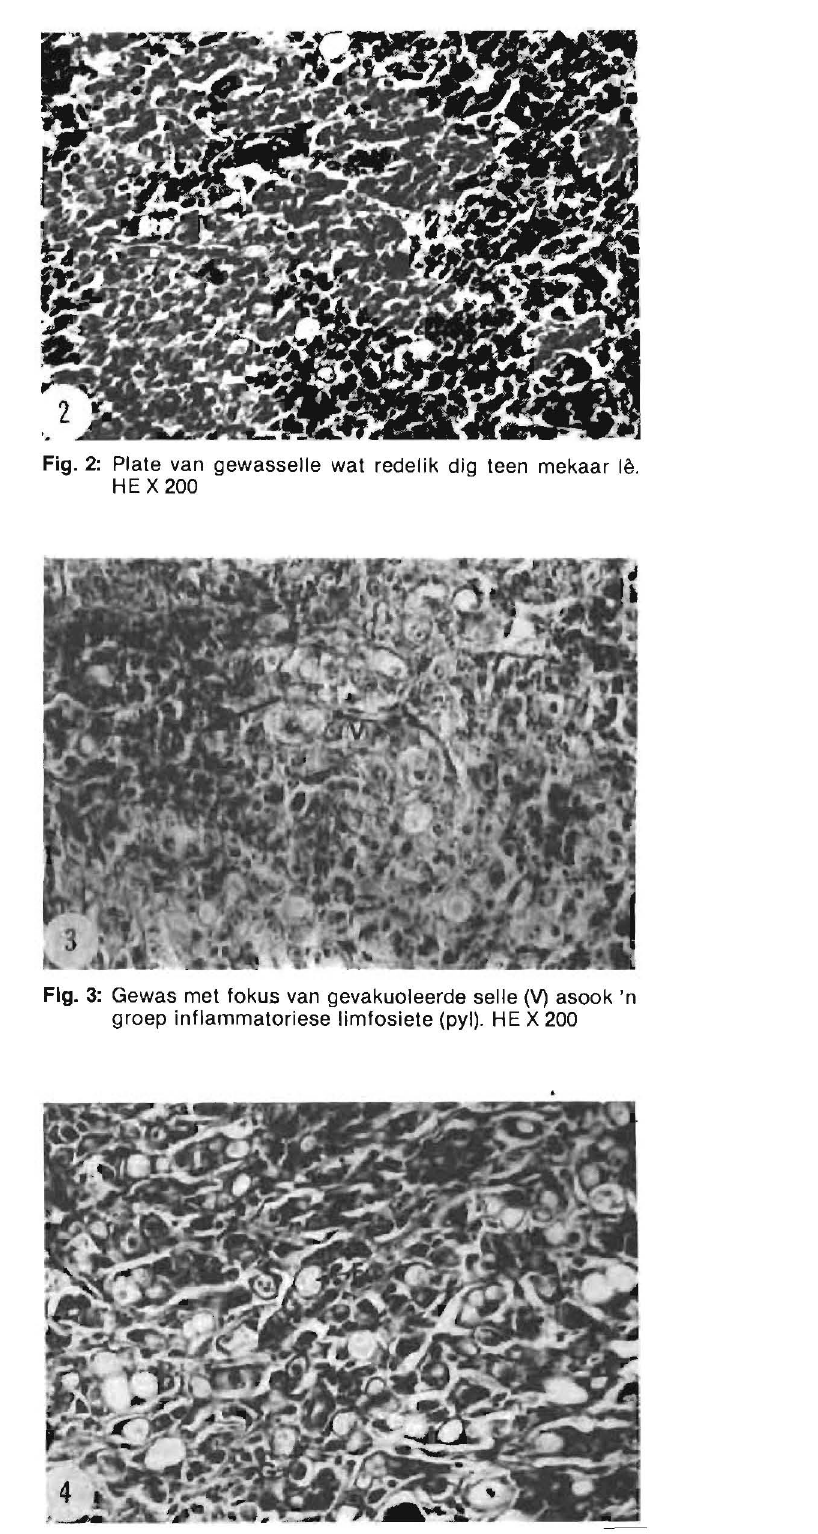
Fig. 4: Groot gevakuoleerde selle. Van die vakuoles bevat globules (G) of fibrillere materiaal (F). HE X 500 en mag enkel of meervoudig wees 2• Die gewas in die hond was ekstensief en noduler in